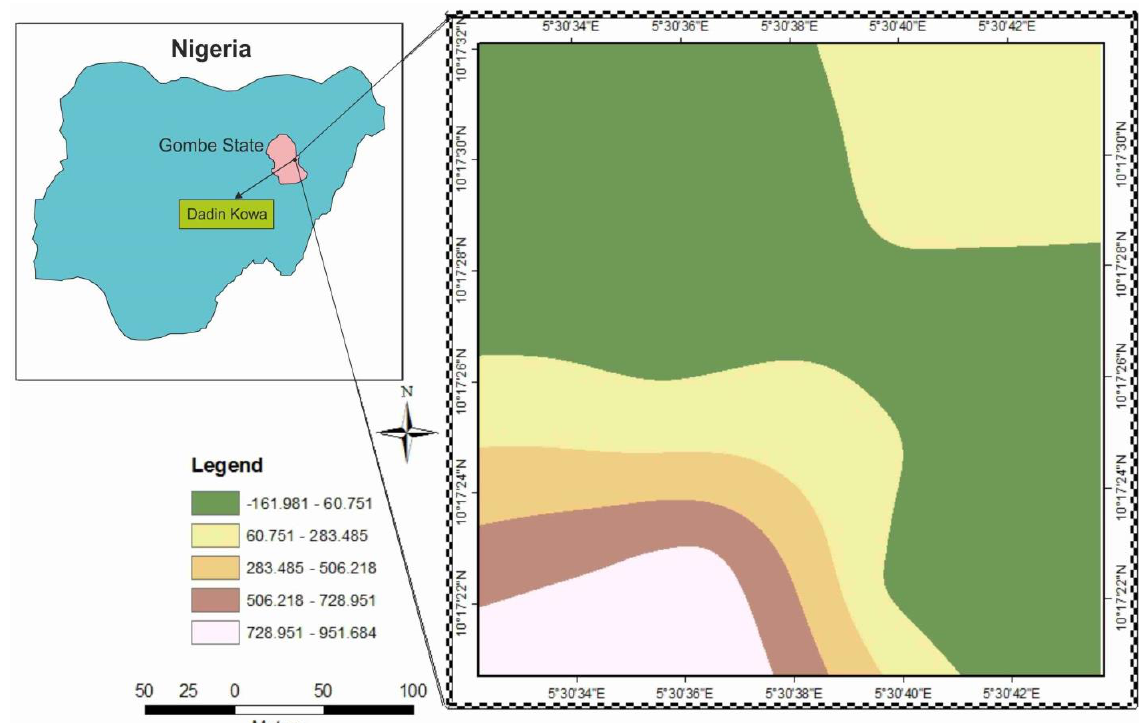
Fig. 8. Distribution of Aquifer Transmissivity across the